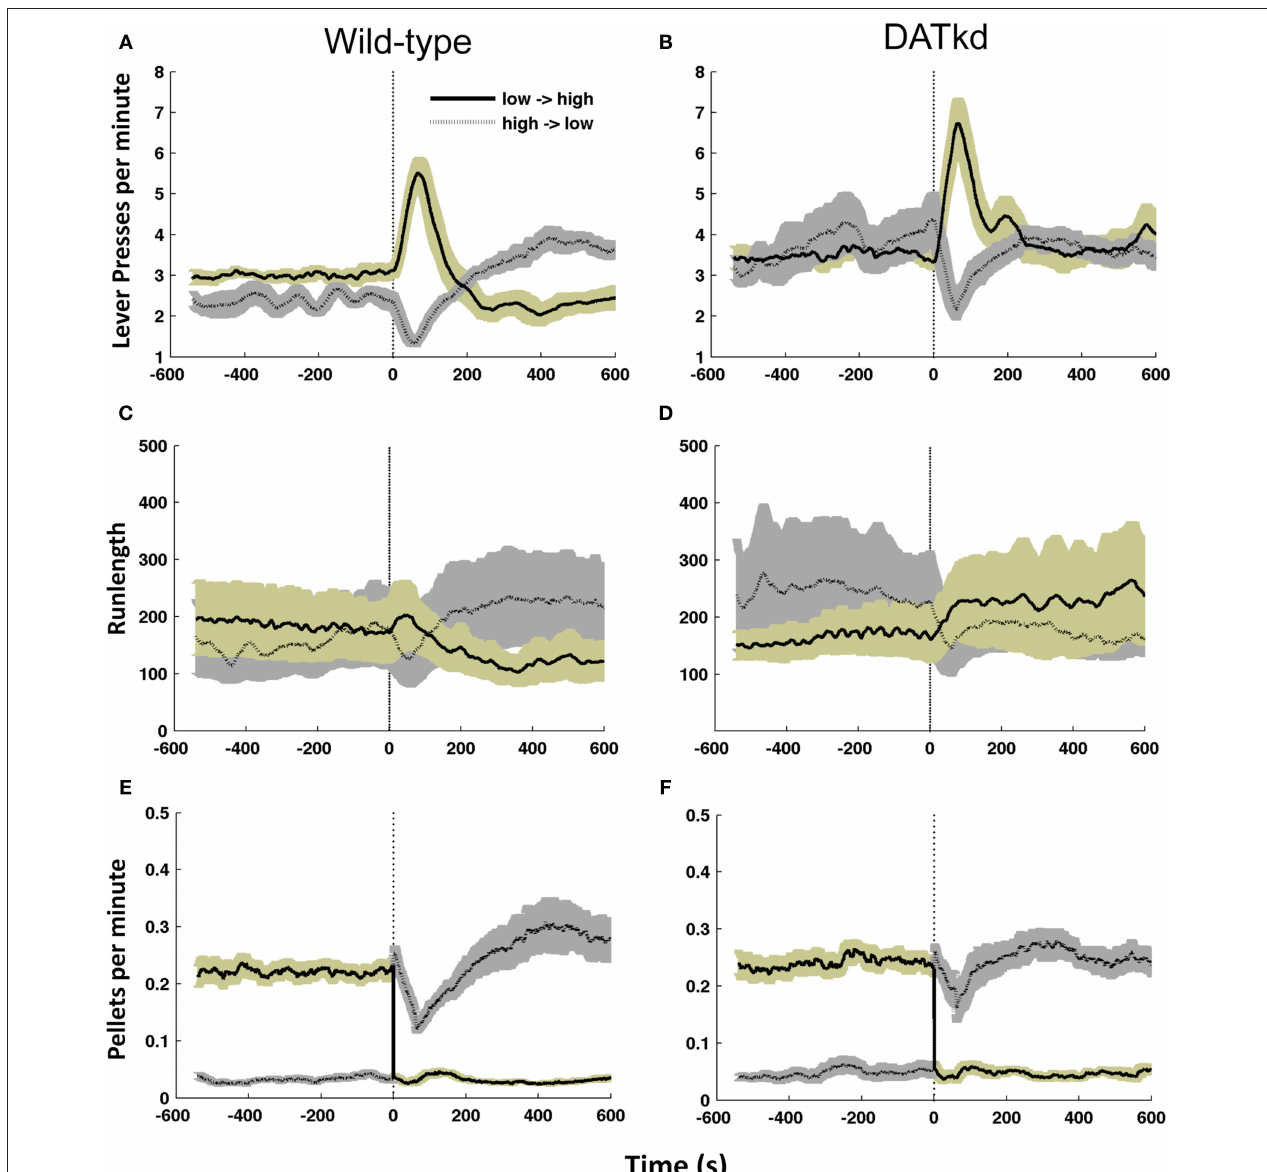
Figure 2 | Mean allocation of effort and runlength on the high and low cost lever following the switch in reward contingency (dashed line). Mean lever presses per minute 10 min before and after reward contingency switch for (A) wild-type and (B) DATkd (genotype × lever × time, p < 0.0001). Mean runlength on each lever for (C) wild-type (D) DATkd (genotype × lever × time,